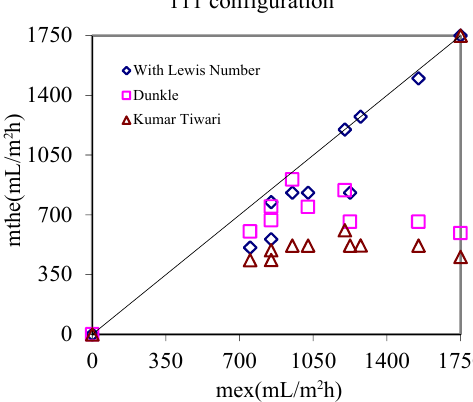
Fig. 6. Comparison of the experimental hourly yield with that obtained by Dunkle, Kumar and Tiwari and Lewis number correlations in SSD model (110 configuration).